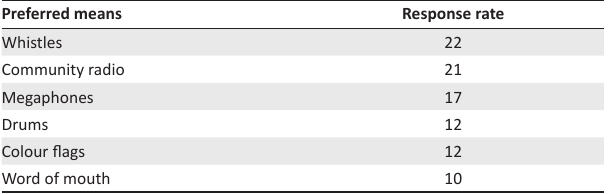
TABLE 5: Response to common means of